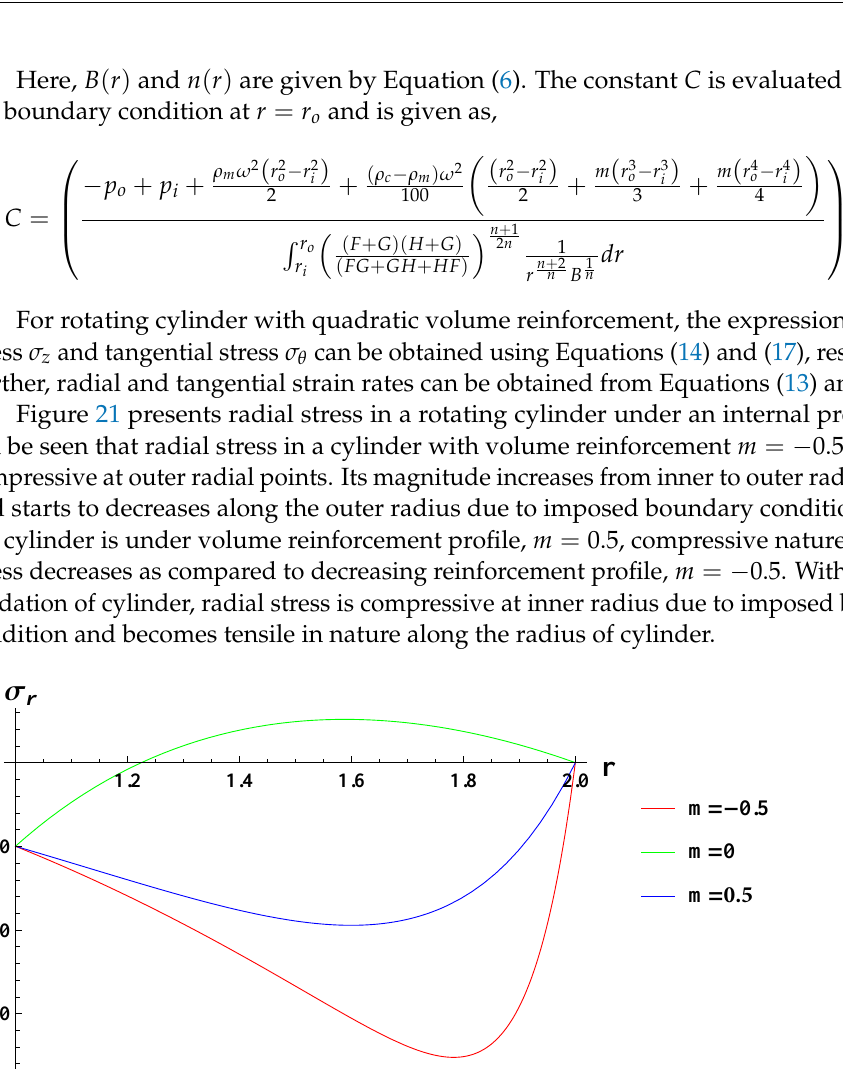
Figure 21. Radial stress (in MPa) along the radius r (in cm) of the cylinder, under the effect of rotation ( ω 2 = 50 rad/s), internal pressure p i = 50 MPa and quadratic volume